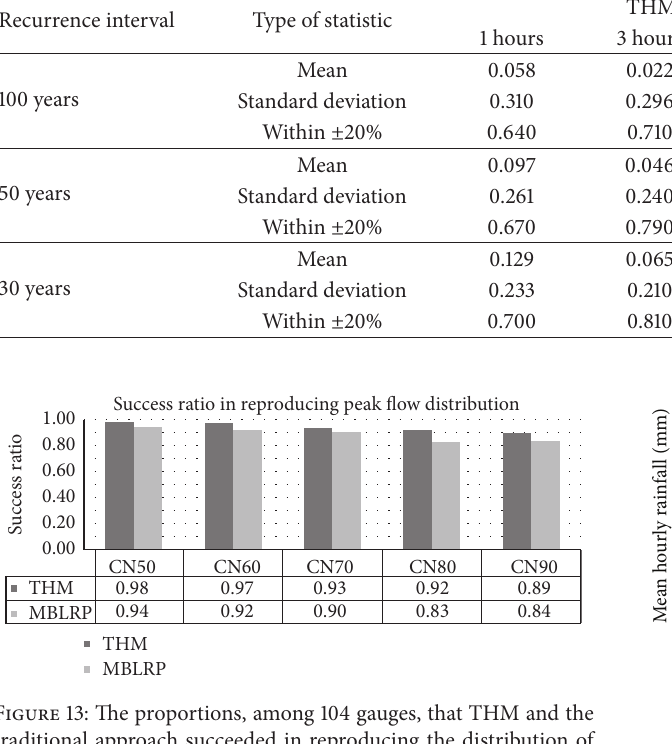
Table 1: Performance comparison between THM and the traditional approach in reproducing design rainfall values. Recurrence interval